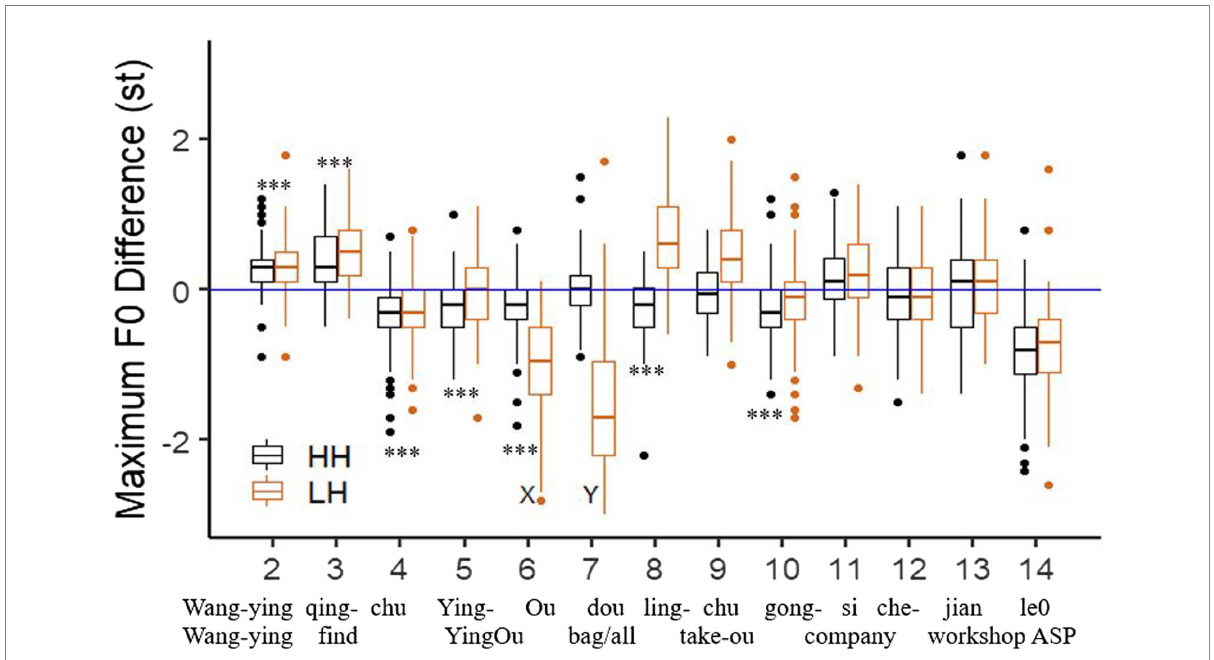
FIGURE 8 Boxplot of the maximum F0 difference between two adjacent H tones, as compared between HH and LH wide-focus sentences. The number in the x -axis (2–14) means that this is the maximum F0 of the current syllable minus the preceding syllable. *** here indicates significant difference between 0 by one-sample t -test in the HH sentences.